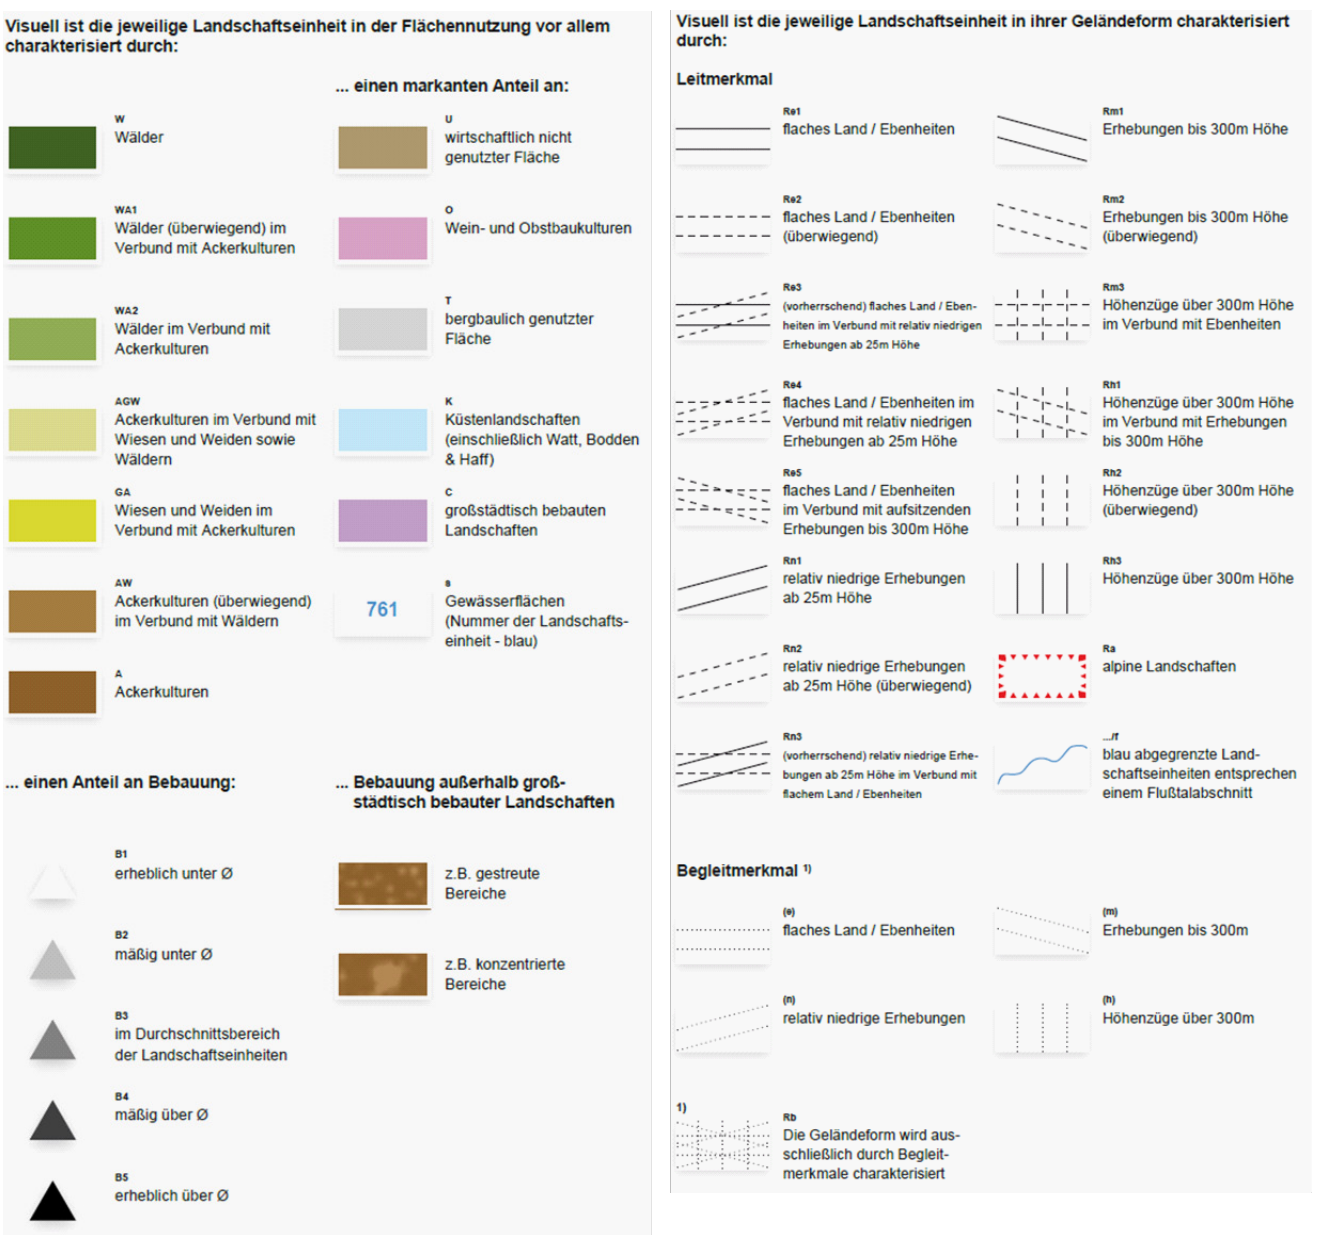
Figure 13: Mapping key for the visual landscape characterisation following J.G. Granö’s conception (Kirkamm,